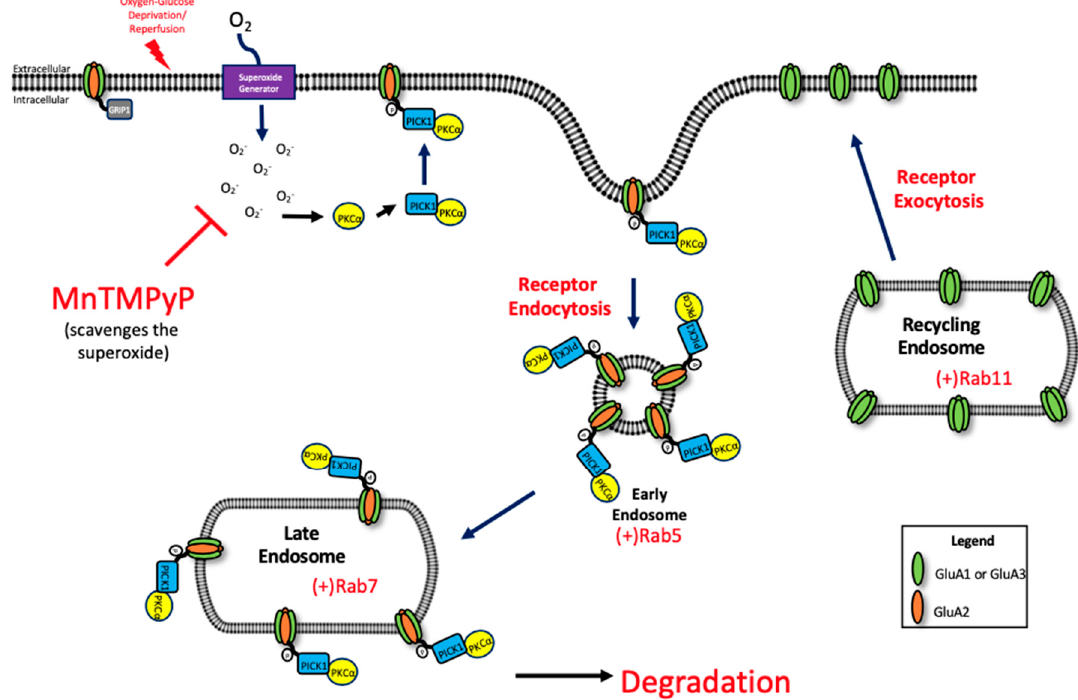
Figure 8. Potential mechanism of oxidative stress-mediated trafficking of GluA1 and GluA2 AMPAR subunits following OGD/R.